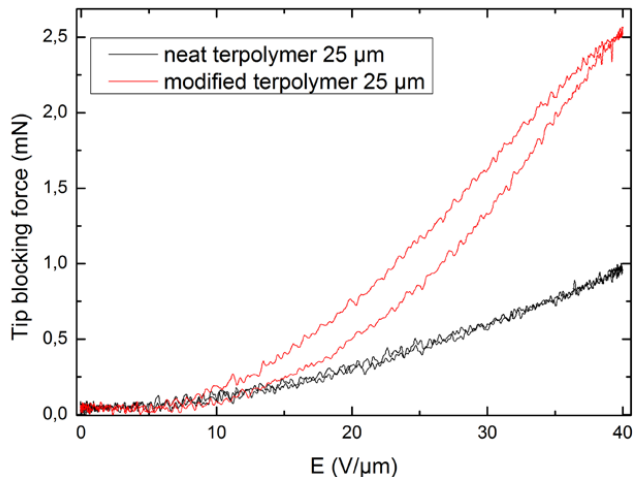
Figure 11. Blocking force versus electric field for two terpolymer compositions.